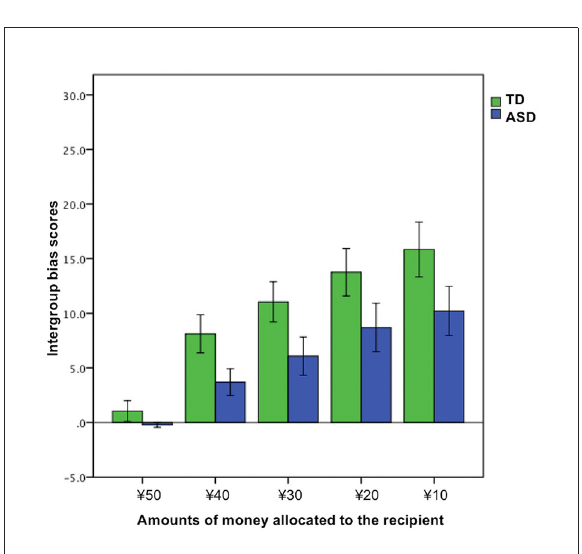
drugs (ASD [with psychotropic drugs] 6.36 ± 7.99, ASD [without psychotropic drugs] 5.03 ± 3.61, p = 0.62).